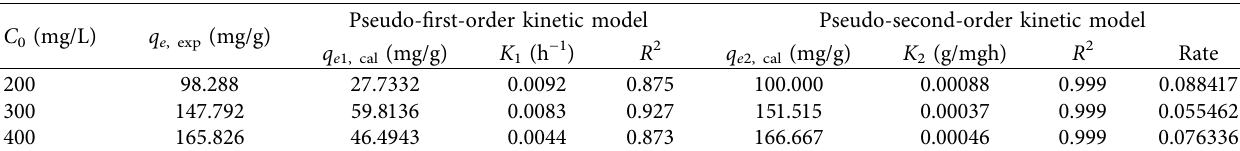
− ions sorption by ZCOBLP. 4 − sorption by ZCOBLP. 4